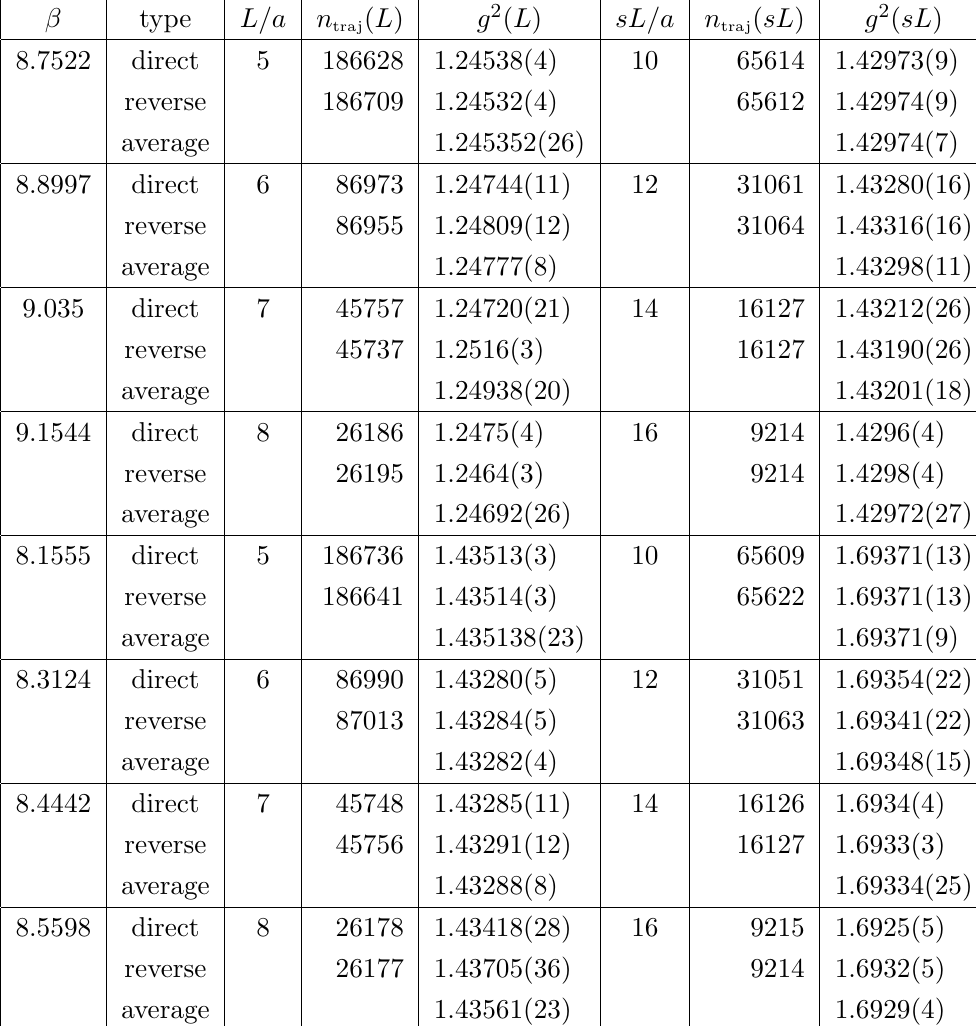
Table 9 . Results for g 2 ( L ) and g 2 ( sL ) from direct and reverse transformations with (cid:1) (cid:17) = 0 : 0001 and n = 1000 in SU(3) Yang-Mills theory, and their average. qq parametrization of the lattice spacing in units of r ln